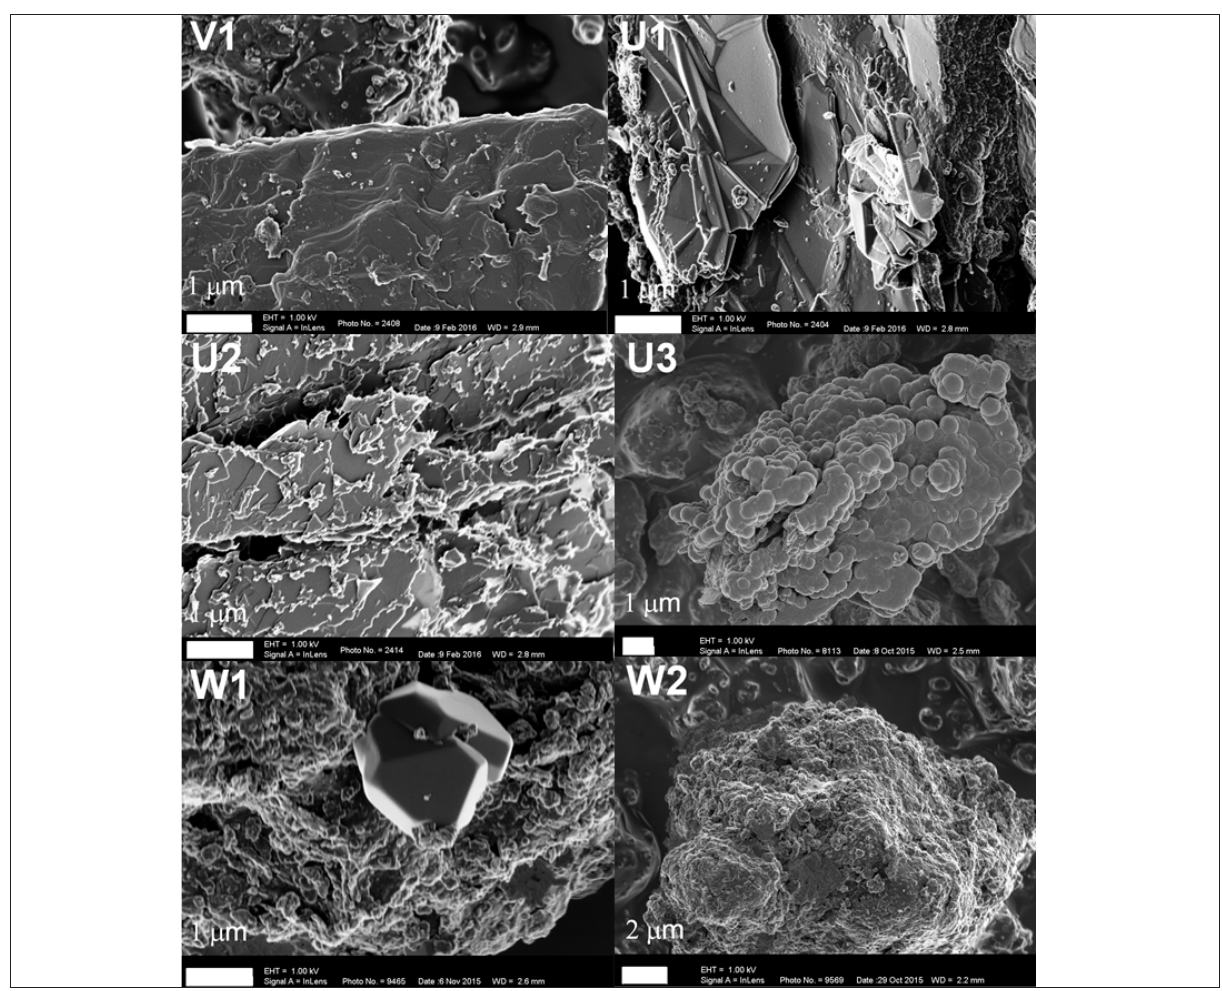
Figure 4: Scanning electron micrographs showing the morphology of powder